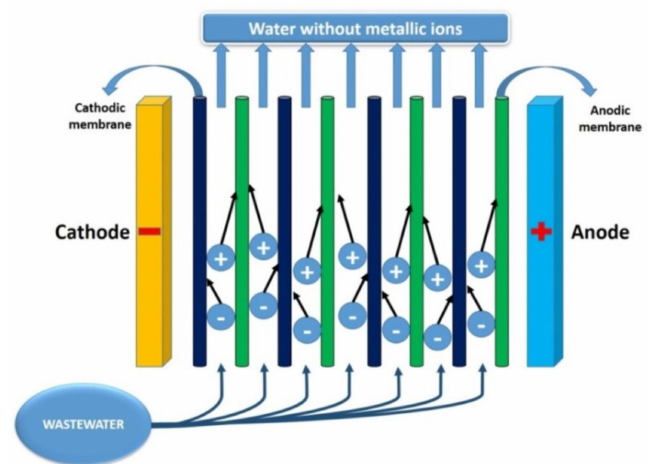
Figure 3. Illustration of the electrodialysis operation principles. The membranes have anionic or cationic property. When the mixture passes through the membranes, the ions are moved to the direction of the anode or